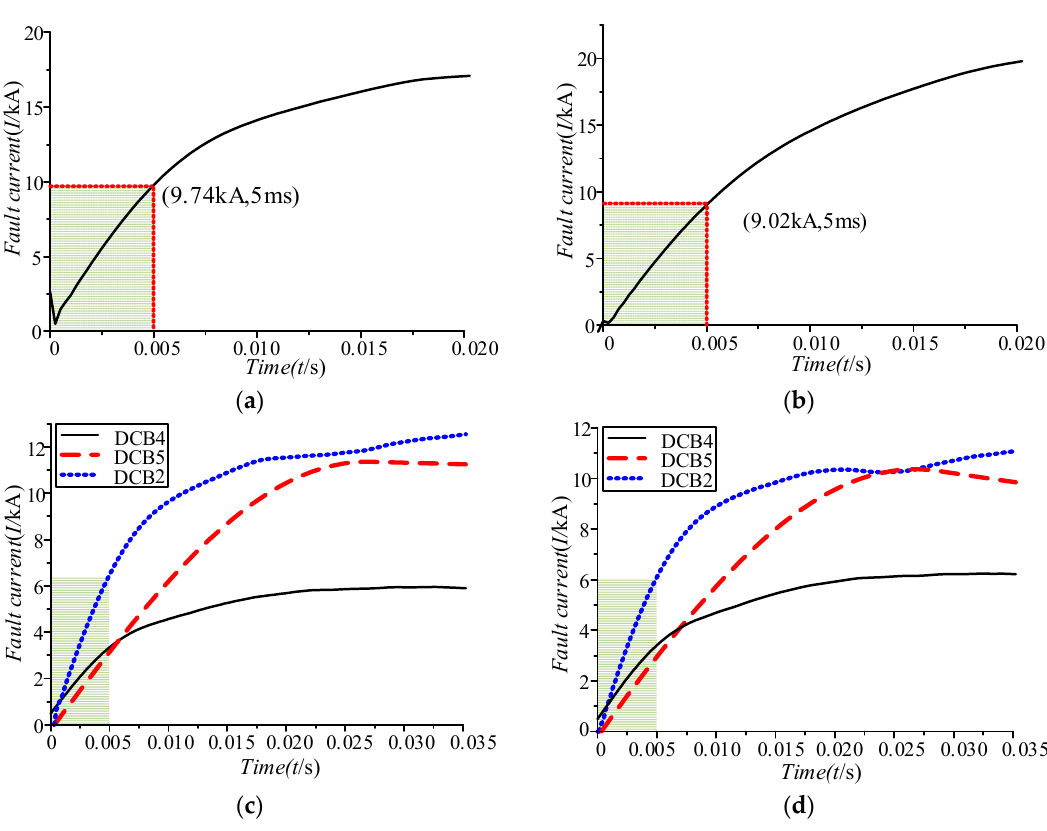
Figure 10. DC breaker fault currents of F5–F8. ( a ) Fault current of DCB5 under Fault F6. ( b ) Fault current of DCB4 under Fault F8. ( c ) Fault currents of DCB2, DCB4, and DCB5 under Fault F5. ( d ) Fault currents of DCB2, DCB4, and DCB5 under Fault F7.